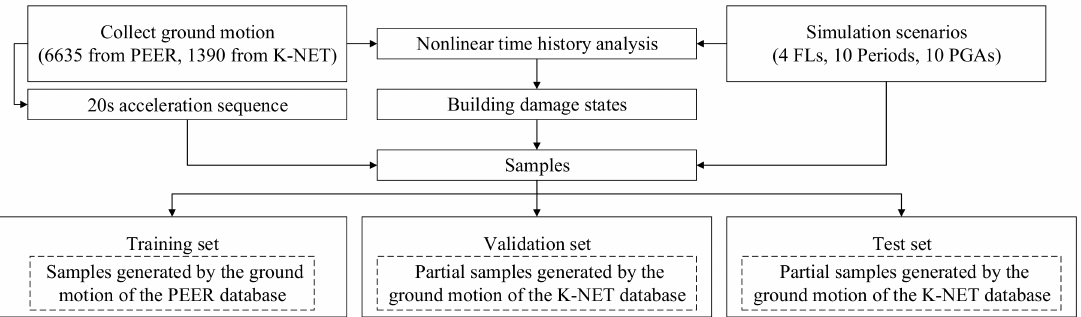
Figure 4. Processing flow of ground motion